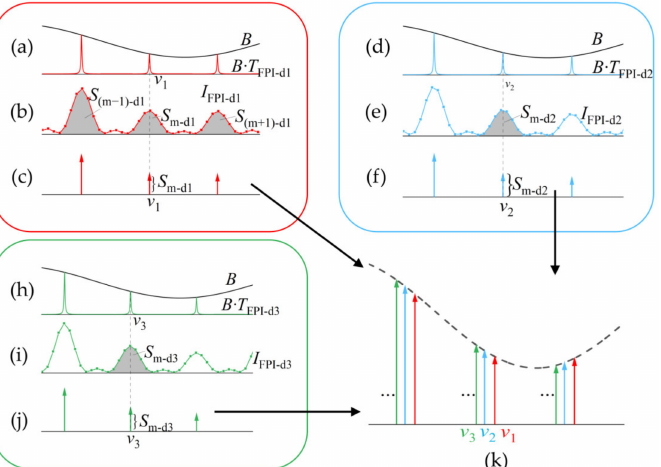
Figure 14. Schematic diagram of the RS-HI super-resolution principle: ( a , d , h ) incident spectrum B and spectrum B · T FPI − d obtained by passing through the FPI with intervals d1, d2, and d3, respectively; ( b , e , i ) low-resolution spectrum obtained by interferometric spectrometer; ( c , f , j ) the energy S of the narrow-band spectrum is obtained based on the integration of the low-resolution spectrum; ( k ) the super-resolution spectrum is obtained by combining all of the S according to the central wavelength of the narrow-band spectrum.